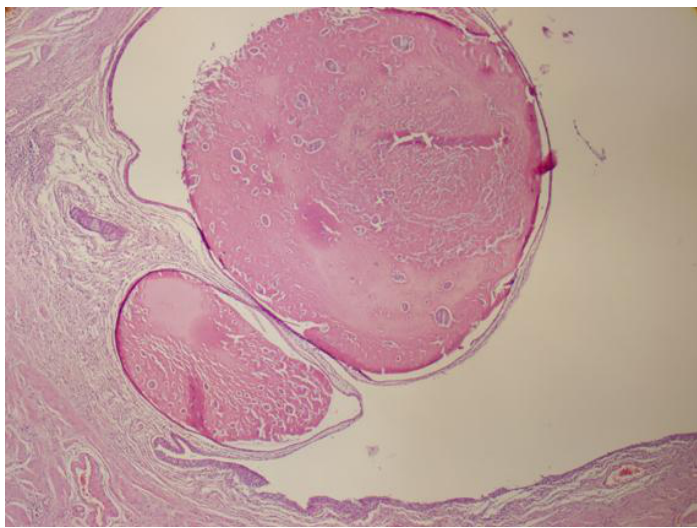
FIGURE 3. Intact cystic structure lined by benign urothelium.